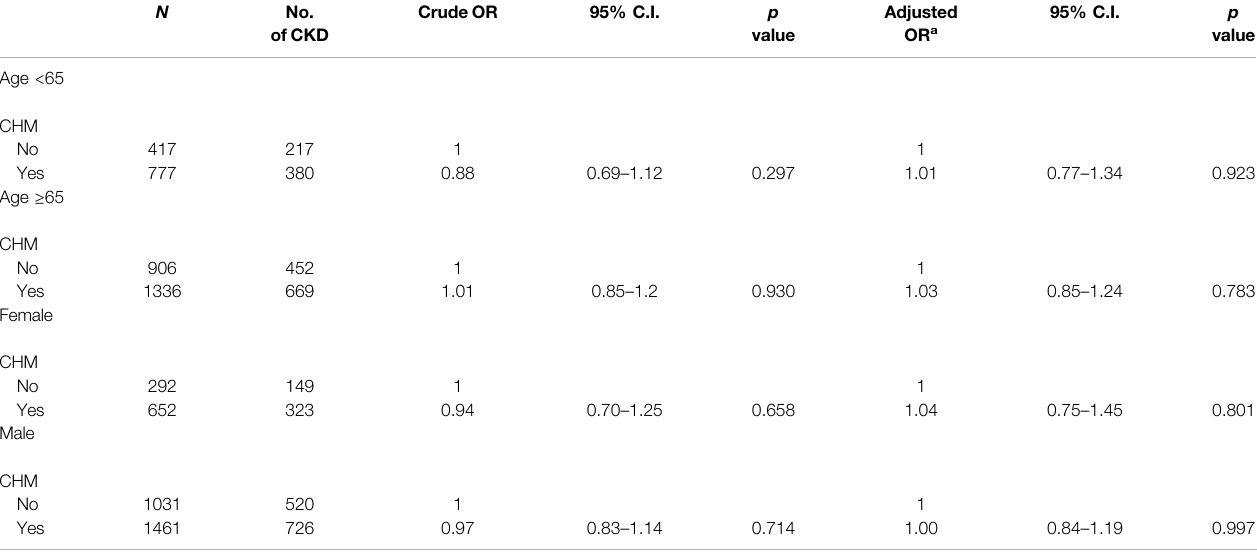
TABLE 3 | Conditional logistic regression of risk of CKD (2).